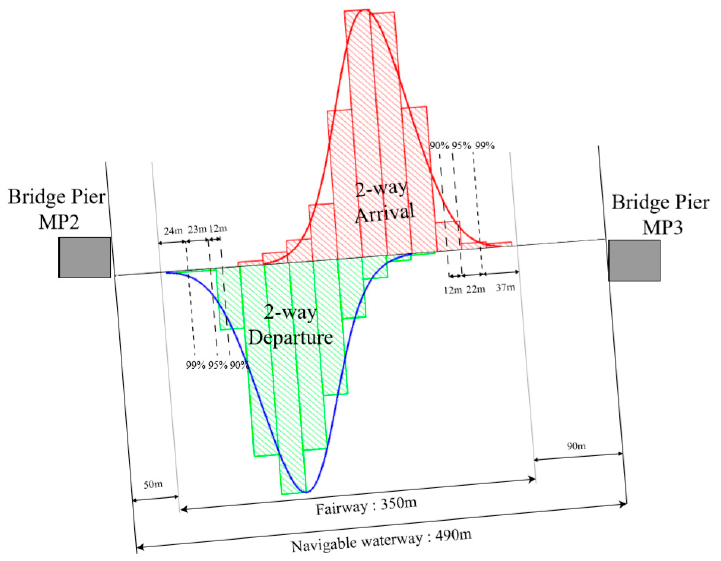
Figure 14. Traffic distribution for the Busan harbor bridge for 2-way traffic.